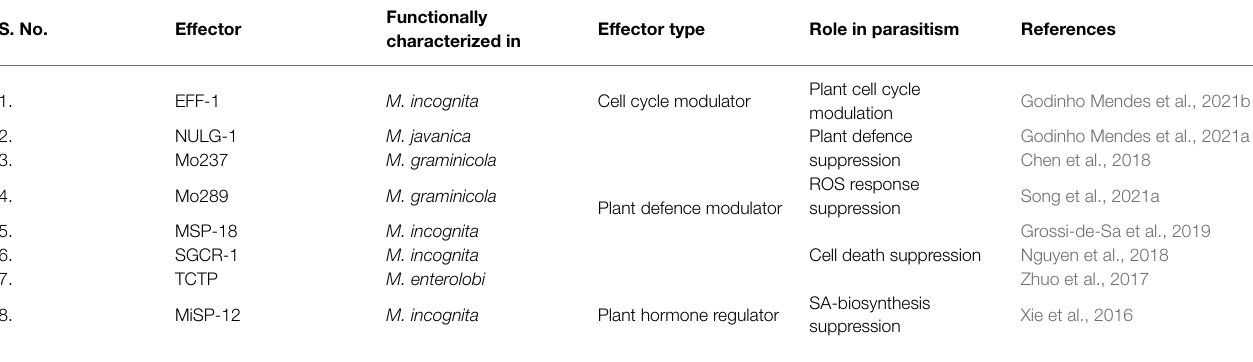
TABLE 2 | Experimentally identified effectors from the dorsal gland of various RKNs. S.